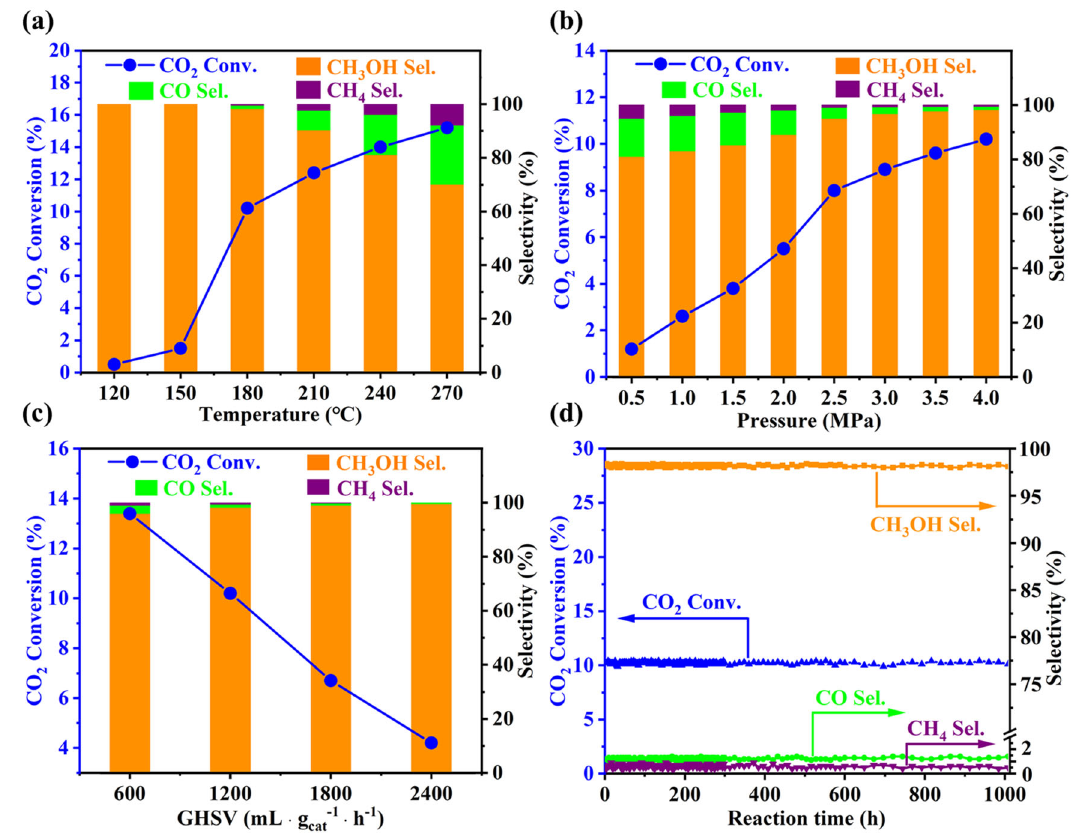
Fig.4|HydrogenationofCO 2 overMo 3 S 4 @NaZSM-5catalystwithfeedgasesof 23% CO 2 , 69% H 2 and balance Ar. a Effect of reaction temperature (4MPa, 1200mLg cat − 1 h − 1 ); b Effectof reactionpressure(180°C, 1200mLg cat − 1 h − 1 ); c Effect